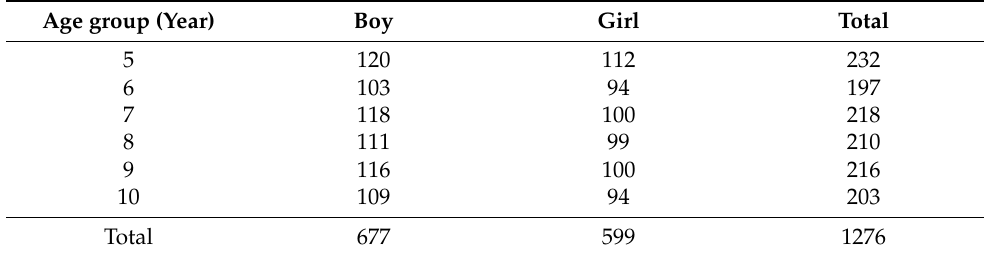
Table 1. The number of children recruited in each age and sex group. Age group